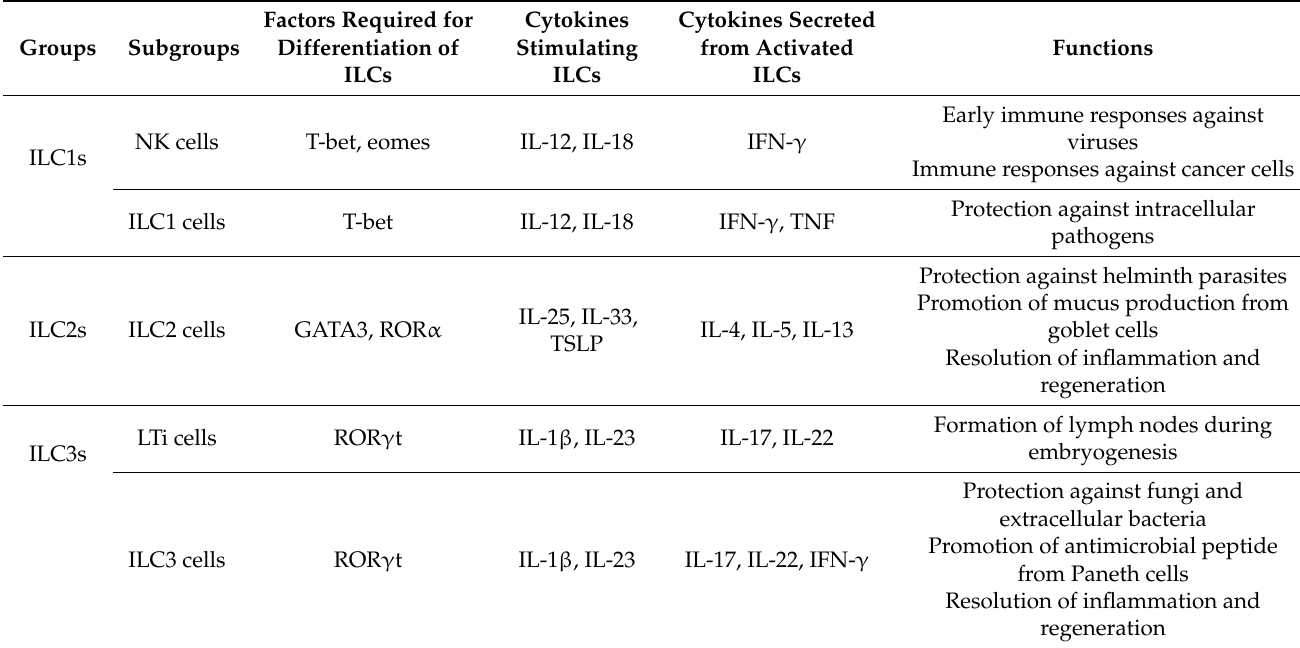
Table 1. ILCs and regulatory